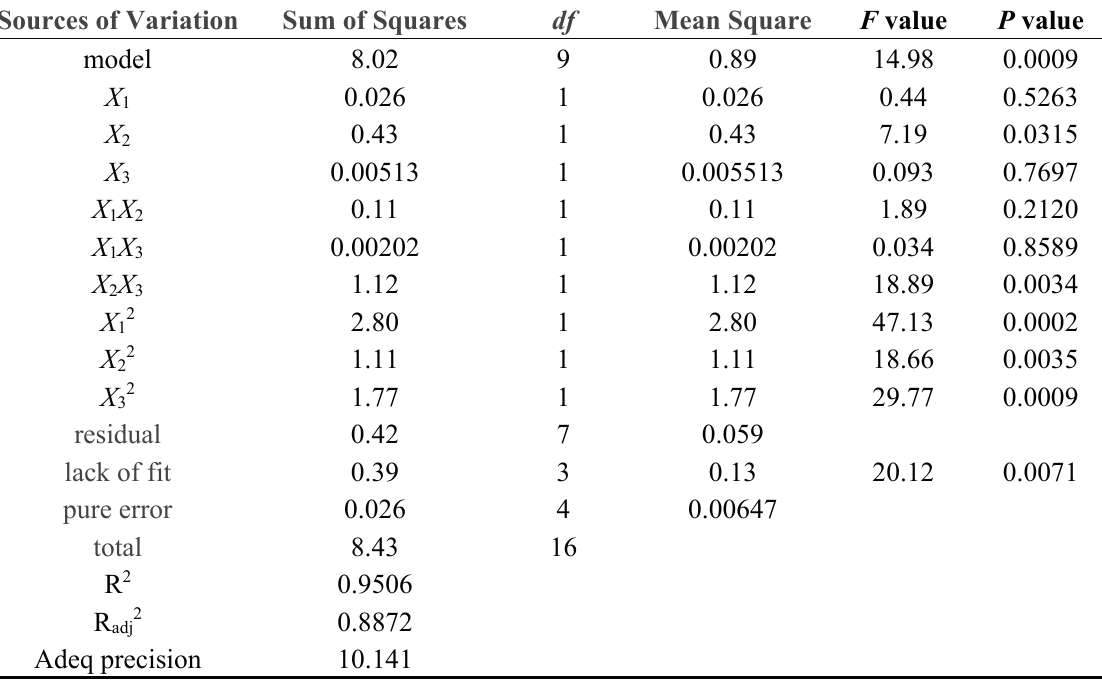
Table 2. Variance analysis of items in regression equation.